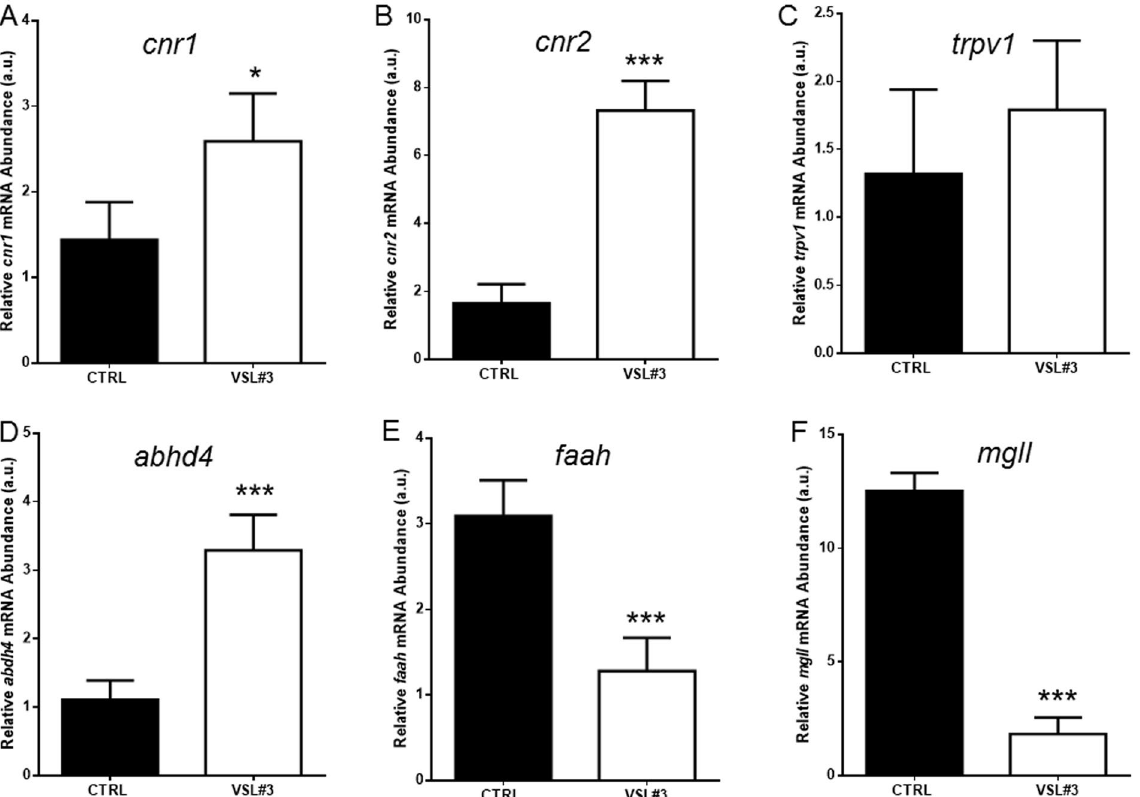
Figure 3. Intestinal ( A ) cnr1 , ( B ) cnr2 , ( C ) trpv1 , ( D ) abhd4 , ( E ) faah and ( F ) mgll mRNA levels by qPCR normalized against act1b and rplp , in control (CTRL) and VSL#3-treated (VSL#3) fish. Values indicate mean ± SD. * p < 0.05; *** p <